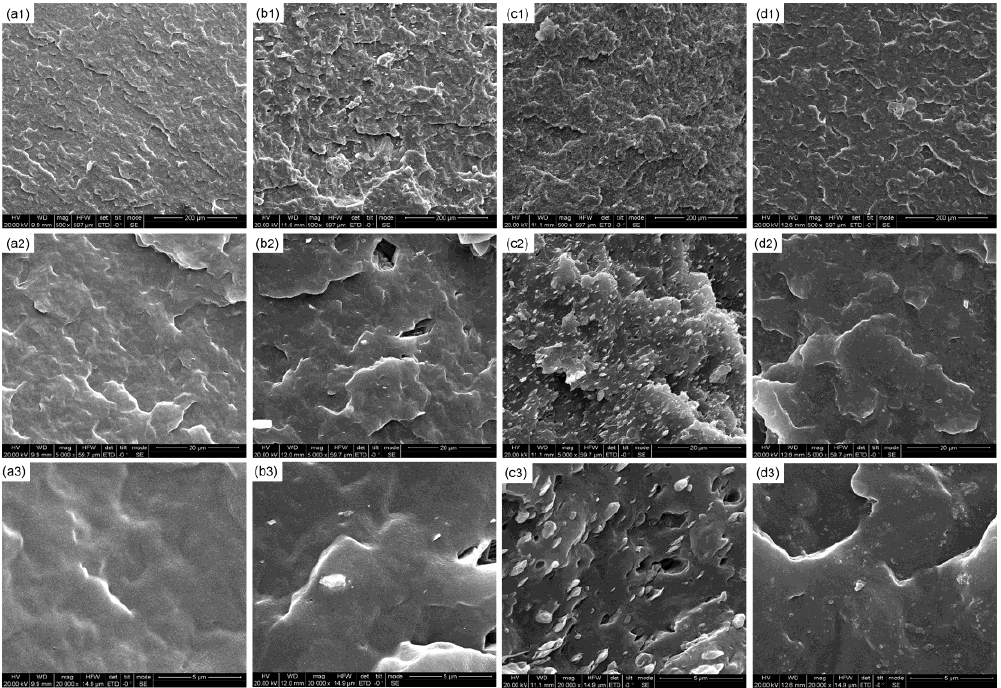
Figure 10. SEM images of the impact-fractured surface of PP ( a1 — 500×, a2 — 5000×, a3 — 20,000×), PP/20%PN-DOPO ( b1 — 500×, b2 — 5000×, b3 — 20,000×), PP/15%PN-DOPO/5%OMMT ( c1 — 500×, c2 — 5000×, c3 — 20,000×) and PP/7%OMMT ( d1 — 500×, d2 — 5000×, d3 — 20,000×) at different magni- fications.